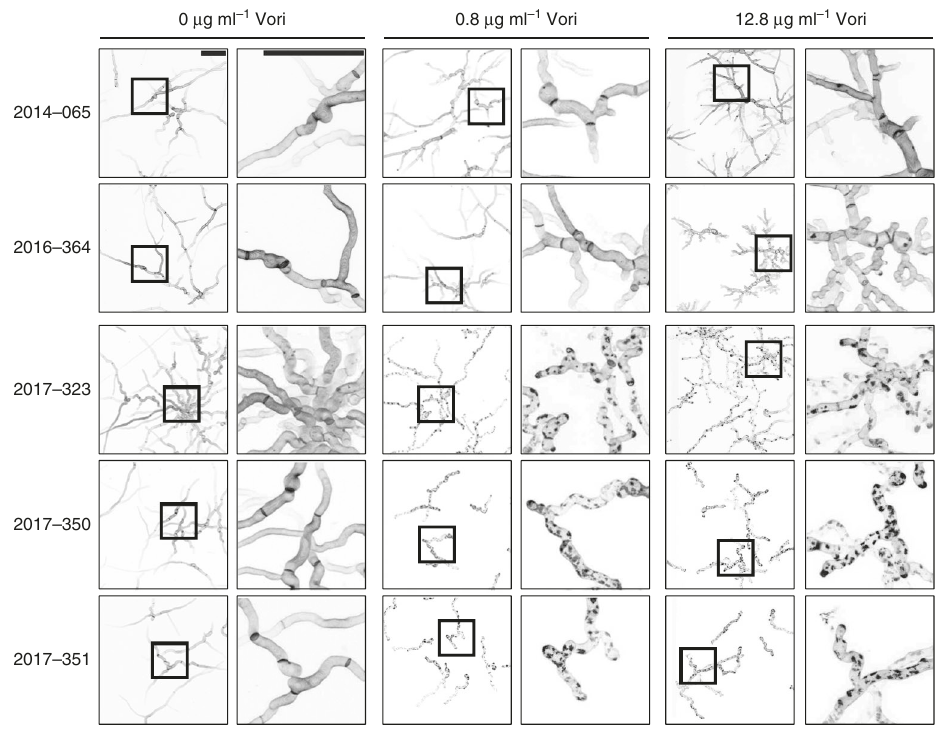
Fig. 9 Azoles trigger patch formation in azole-susceptible but not in azole-resistant A . fumigatus clinical isolates. Conidia of three azole-susceptible (2017 – 323, 2017 – 350, 2017 – 351) and two azole-resistant (2014 – 065, 2016 – 364) clinical isolates of A . fumigatus were inoculated in Sabouraud medium. After 10 h incubation at 37 °C, medium was supplemented with the indicated amount of voriconazole. After additional 10 h incubation, hyphae were stained with calco fl uor white, fi xed and analyzed with a confocal laser scanning microscope. Depicted are representative images of optical stacks of the calco fl uor white fl uorescence (chitin) that cover the hyphae in focus. The right panels show magni fi cations of the framed sections in the panels shown on the left. Bars represent 50 μ m and are applicable to all respective